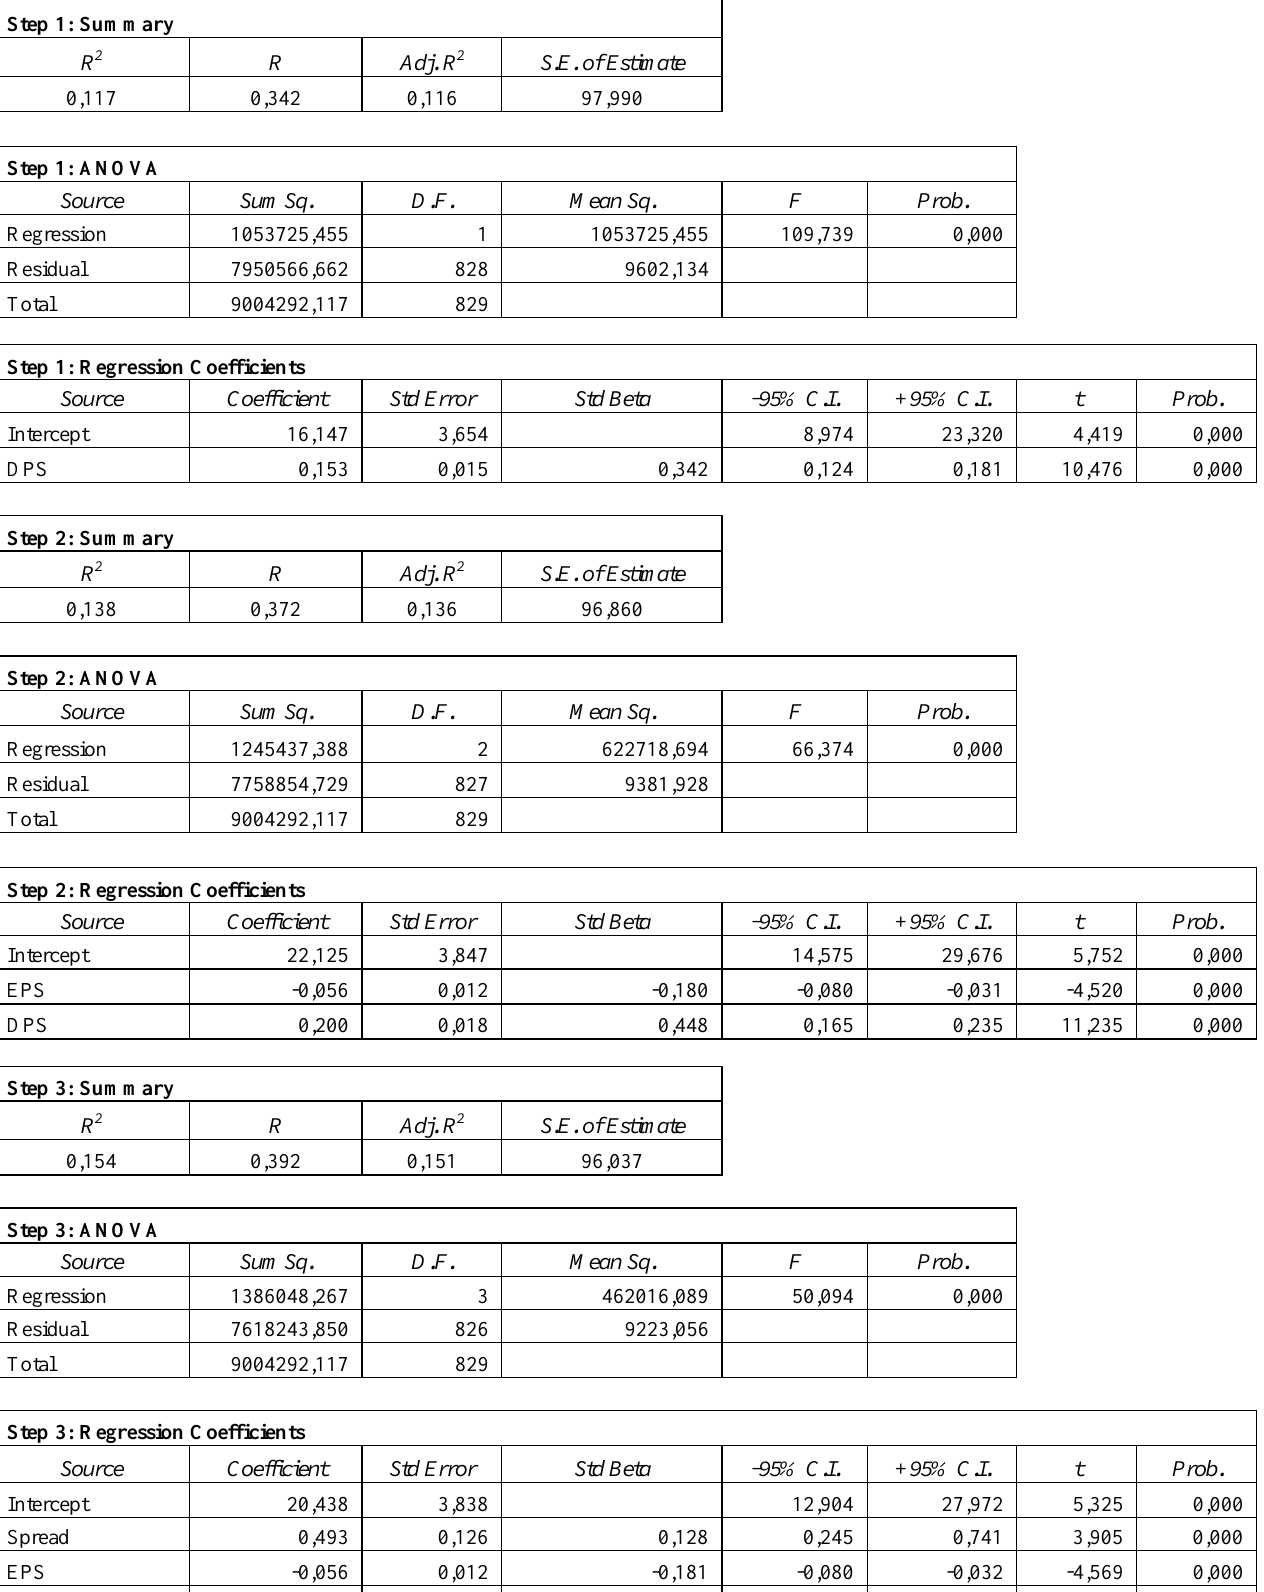
Table 5: Stepwise regression of shareholders’ returns with Spreads and other independent variables, excluding